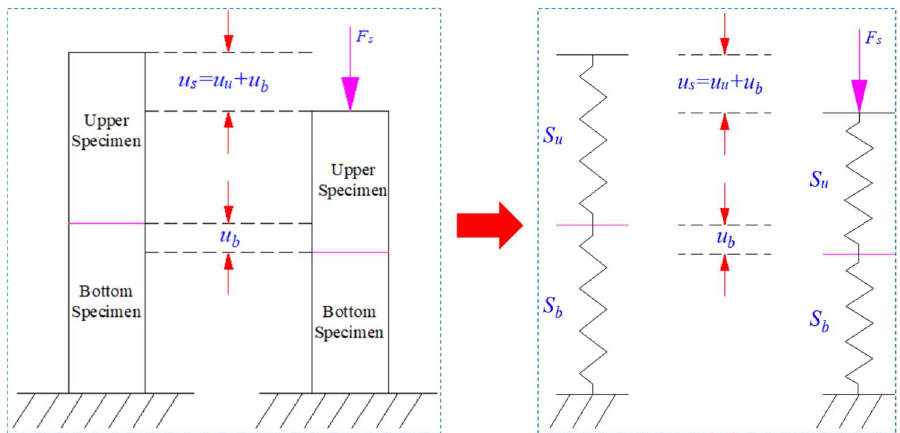
19 of 26 Figure 15. Local displacement evolution of upper and bo(cid:308)om specimens. 5. Discussion The related numerical results and experimental results were consistent as a whole. The common conclusion could be obtained that the unbalanced deformation characteris- tics of serial coal pillar specimens was presented. The balanced bearing characteristics were also exhibited. In order to make a deeper illustration about the related phenomenon, a schematic model of serial coal pillar specimens was established in the following section. Then, the progressive fracturing mechanism of serial coal pillar specimens with different UCS was investigated. 5.1. Schematic Model of Serial Coal Pillar Specimens Figure 16 showed the schematic model of serial coal pillar specimens with different strength. In the one-degree-of-freedom system, two nonlinear and inelastic coal pillar